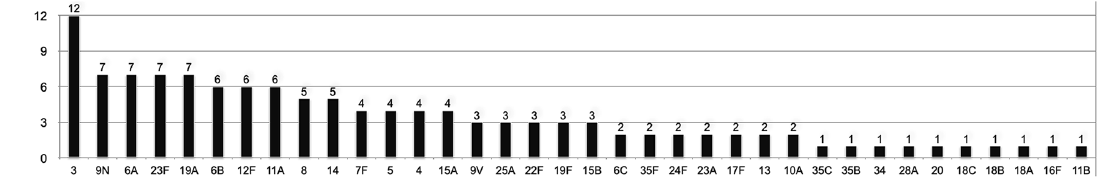
Figure 1. Distribution of serotypes in 123 strains on episodes of Streptococcus pneumoniae bacteremia in cancer